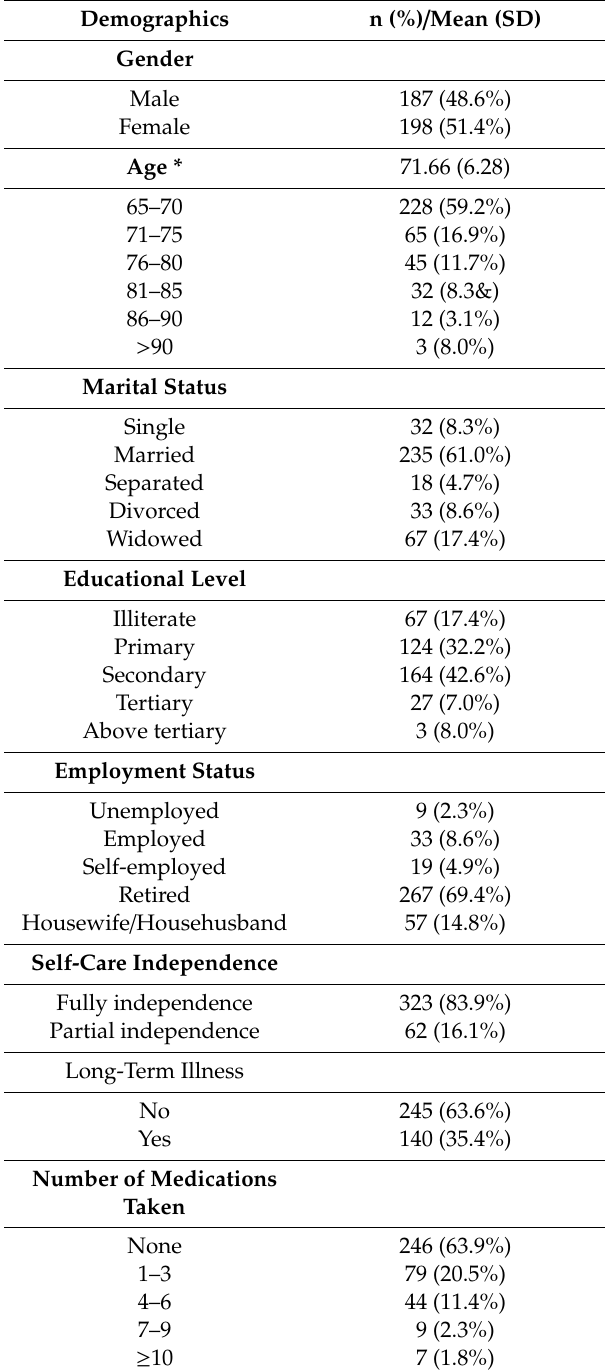
Table 1. Demographic characteristics (n =